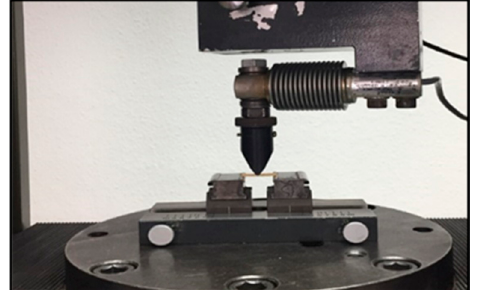
Figure 5. Zwick testing machine measuring flexural strength.